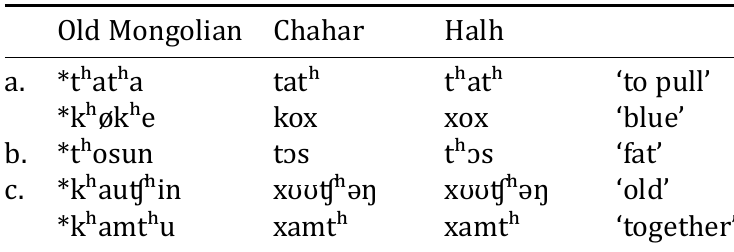
Table 1: The pattern of completed, regressive dissimilation in